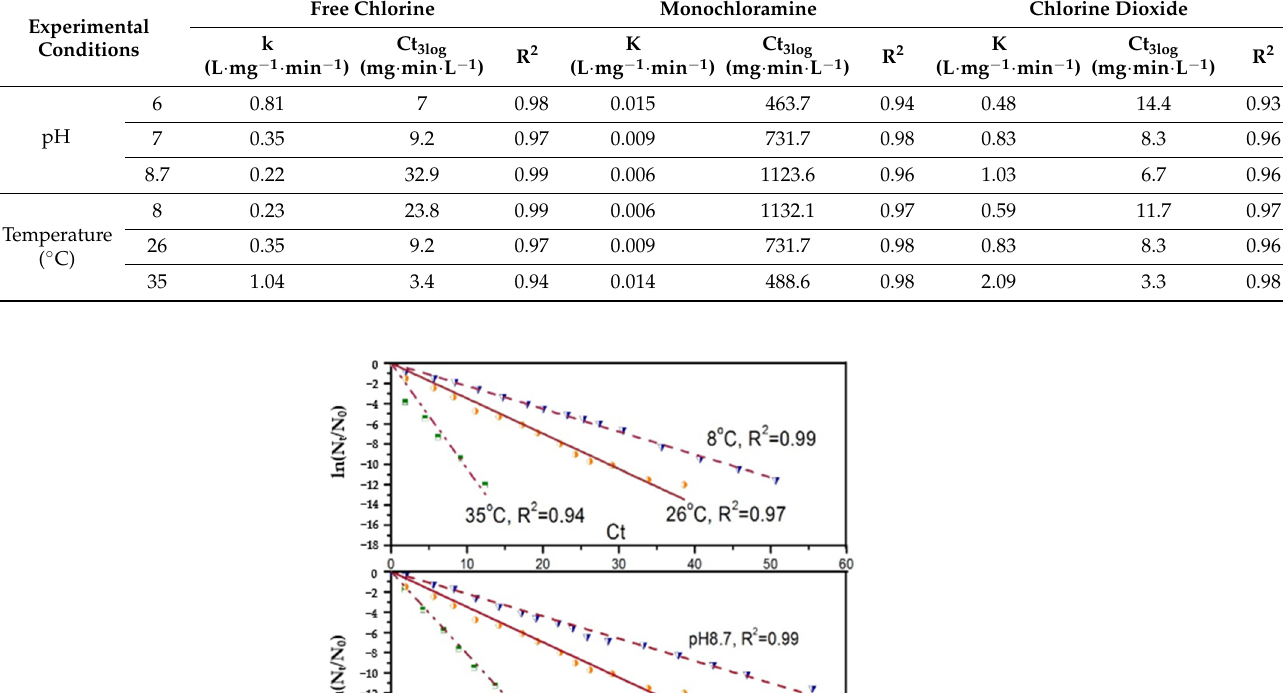
Table 1. Effect of pH and temperature on N. europaea inactivation.